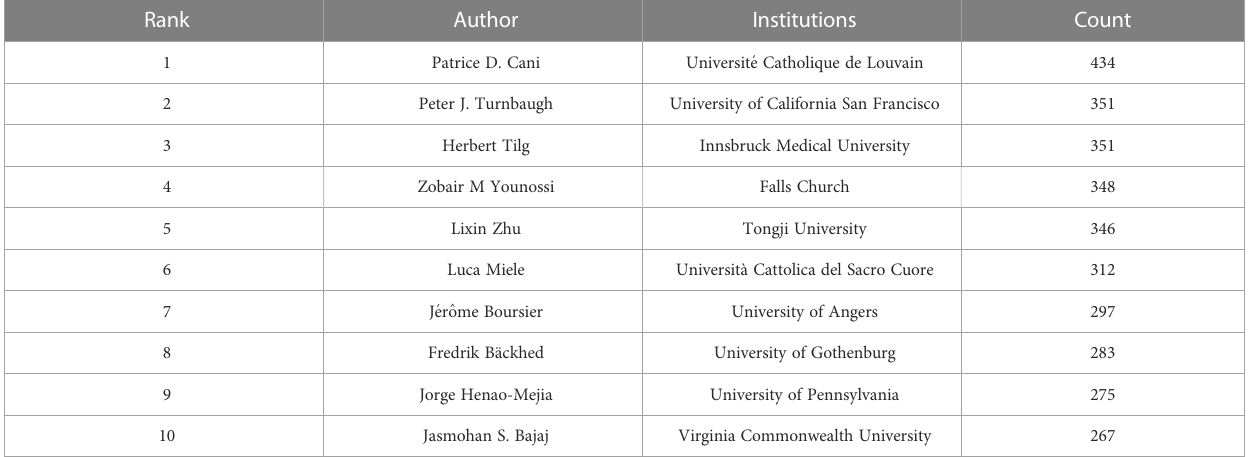
TABLE 3 Top 10 co-cited authors on the gut-liver axis in